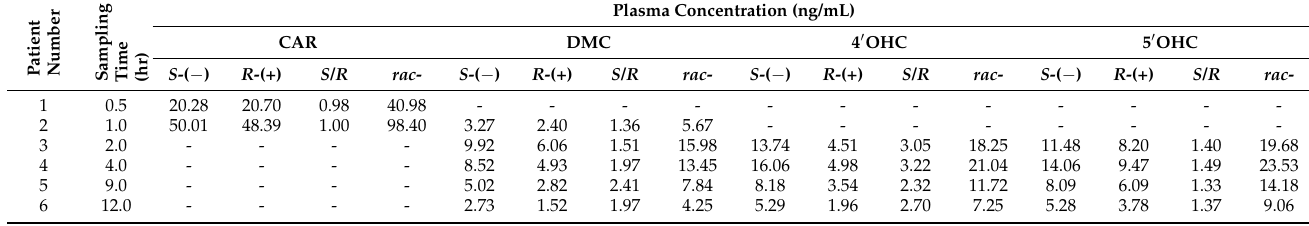
Table 3. Plasma concentrations of CAR and metabolite enantiomers in randomly collected blood samples obtained from cardiovascular patients after oral administration of 25 mg racemic CAR (12.5 mg = 30.75 μ mol per enantiomer) at the respective times of blood sampling.